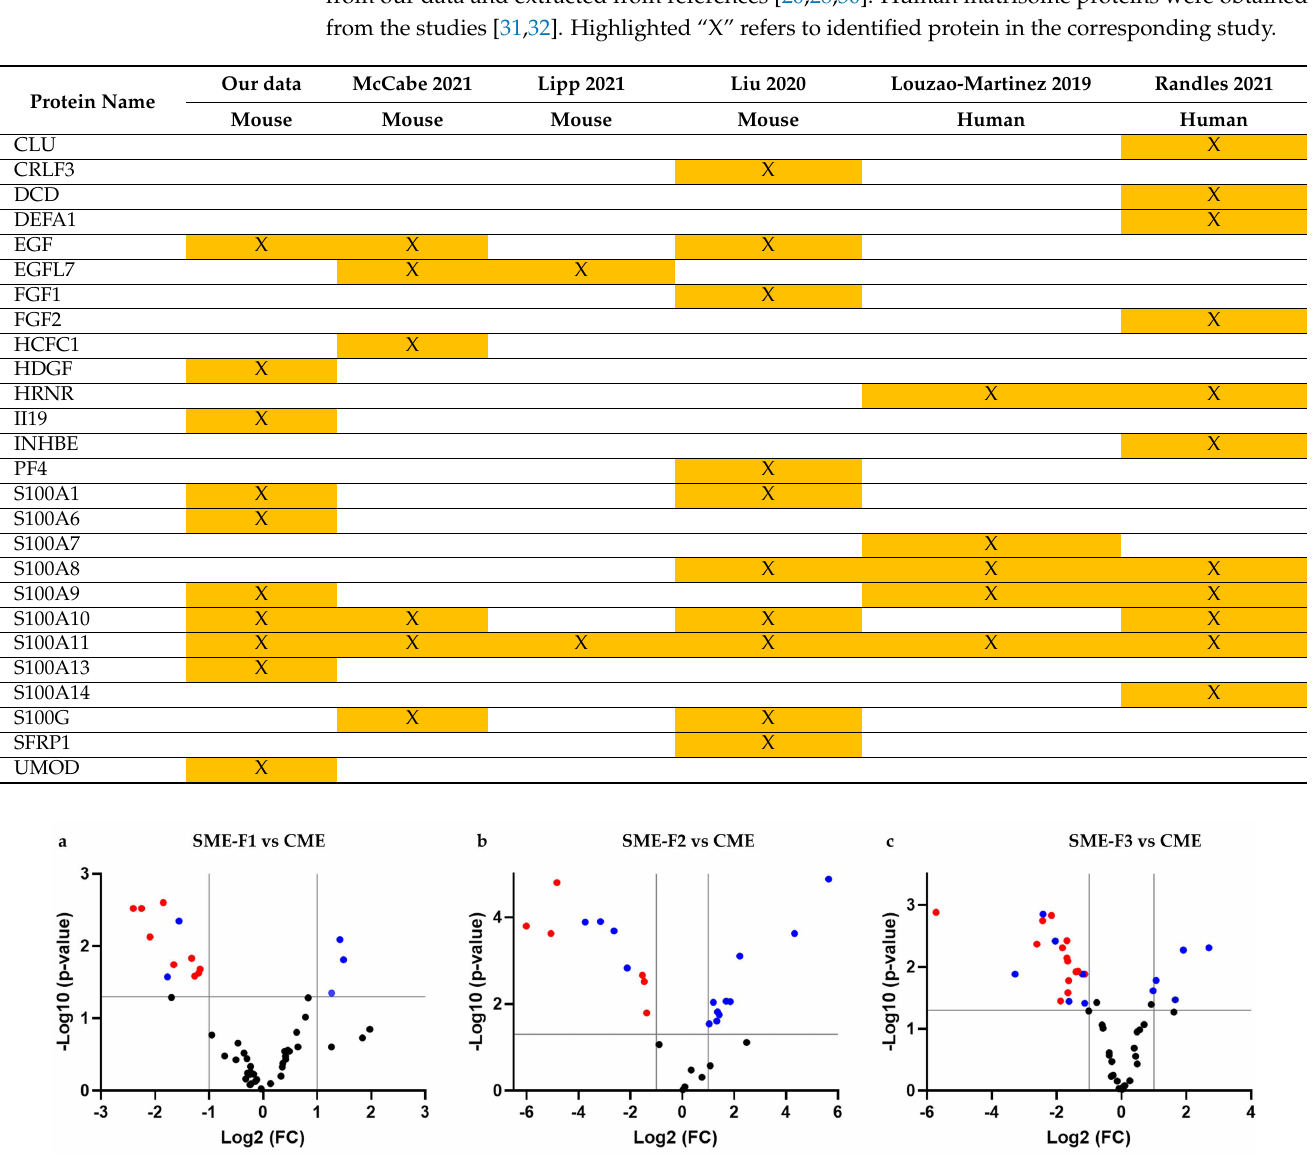
Figure A3. Quantitative comparison of protein extraction levels between SME fractions and CME. Volcano plots represent significant differences in protein abundances (FC > 2, p -value < 0.05) between ( a ) SME (fraction 1) and CME, ( b ) SME (fraction 2) and CME and ( c ) SME (fraction 3) and CME. Top-right-hand sides of volcano plots are proteins that were significantly higher in SME fractions. Top-left-hand sides are proteins that were significantly higher in CME. Blue dots indicate Matrisome- associated proteins and red dots indicate core matrisome proteins that were significantly higher in either SME fractions or